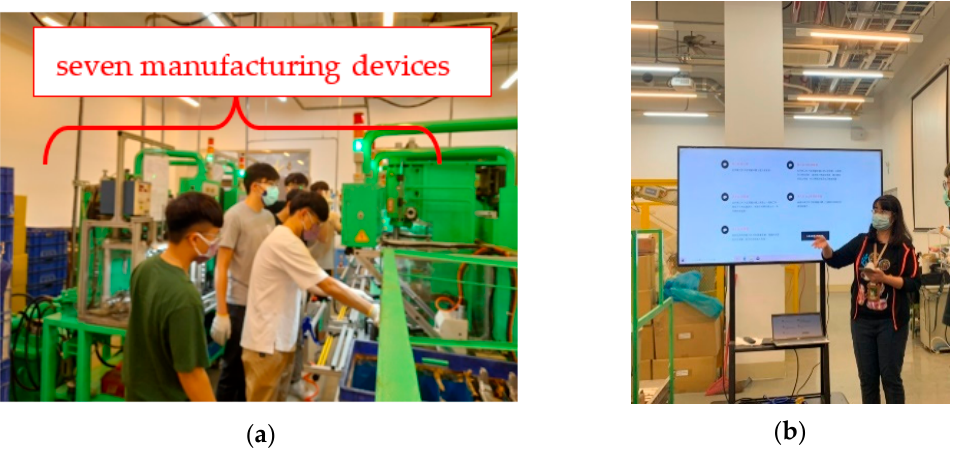
Figure 2. The image data this study used. ( a ) Side view. ( b ) front view.